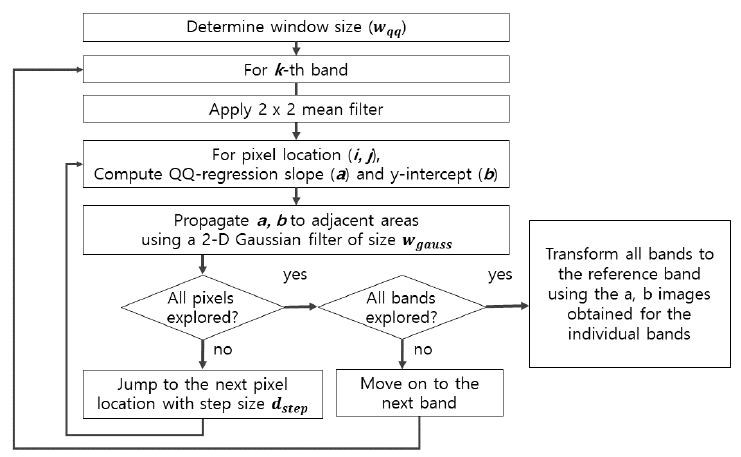
Figure 13. The flow chart of the proposed algorithm.